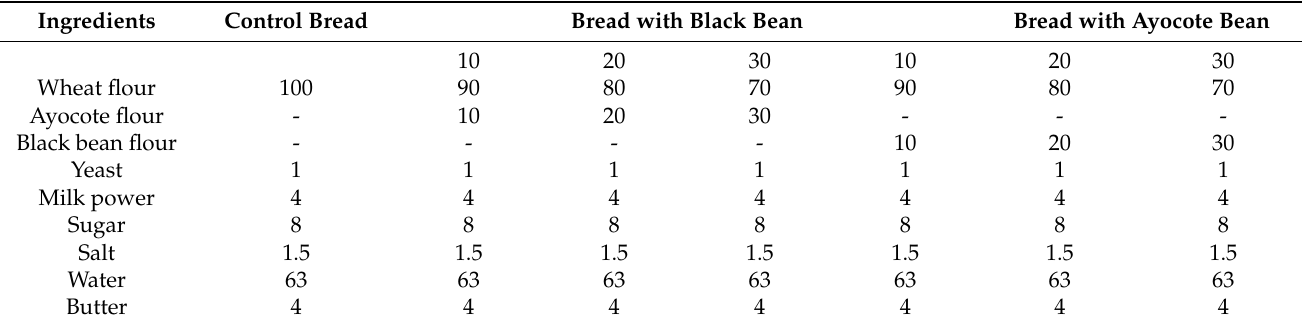
Table 1. Formula (in baker’s percent) of breads added with black bean and ayocote bean. Ingredients Control Bread Bread with Black Bean Wheat